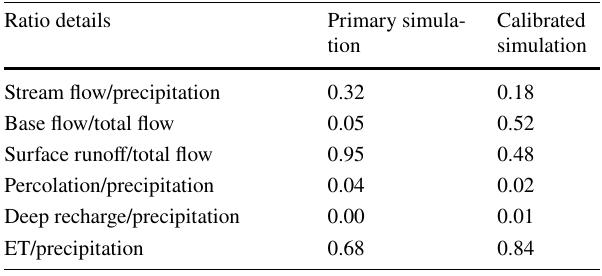
Table 7 SWAT model simulation of water balance